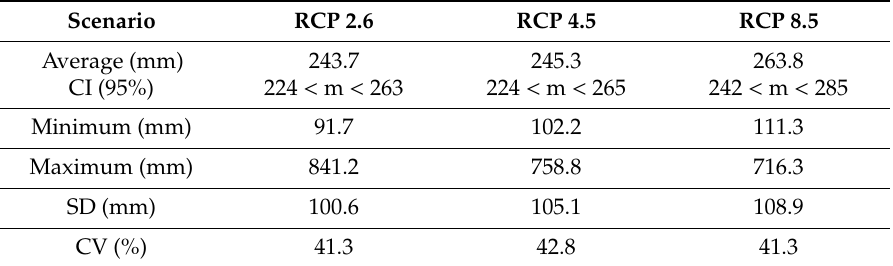
Table 4. Annual rainfall statistics predicted by climate scenarios RCP 2.6, RCP 4.5 and RCP 8.5. CI: Confidence Interval; SD: Standard